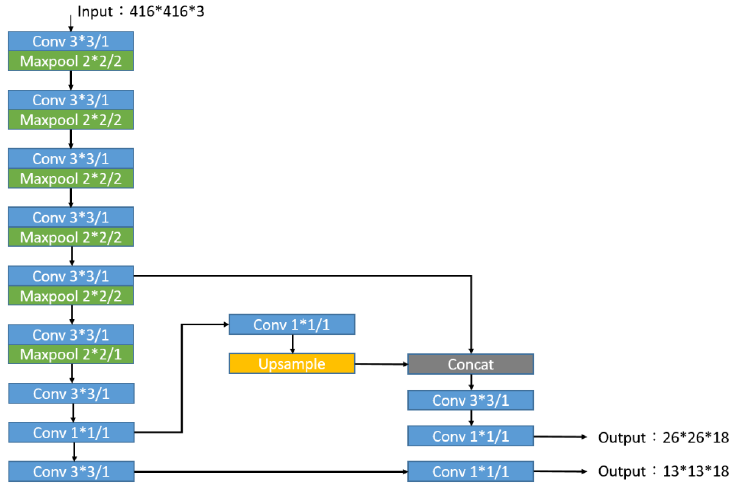
Figure 4. Tiny-YOLOv3 network architecture in method